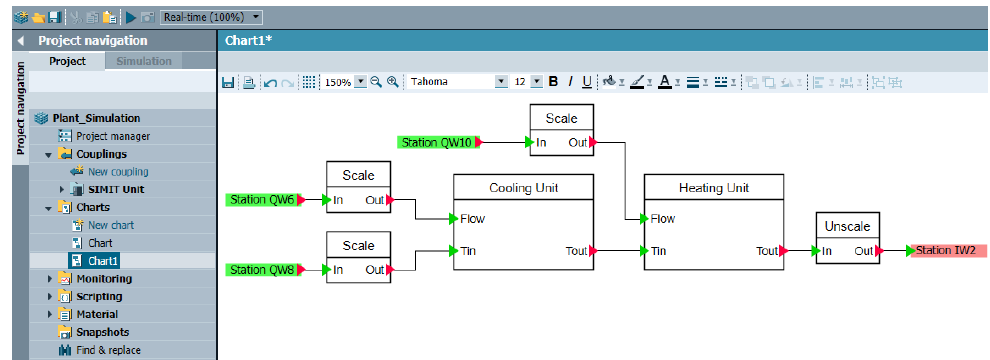
Figure 3. Simulation of the air conditioning unit in Siemens SIMIT.